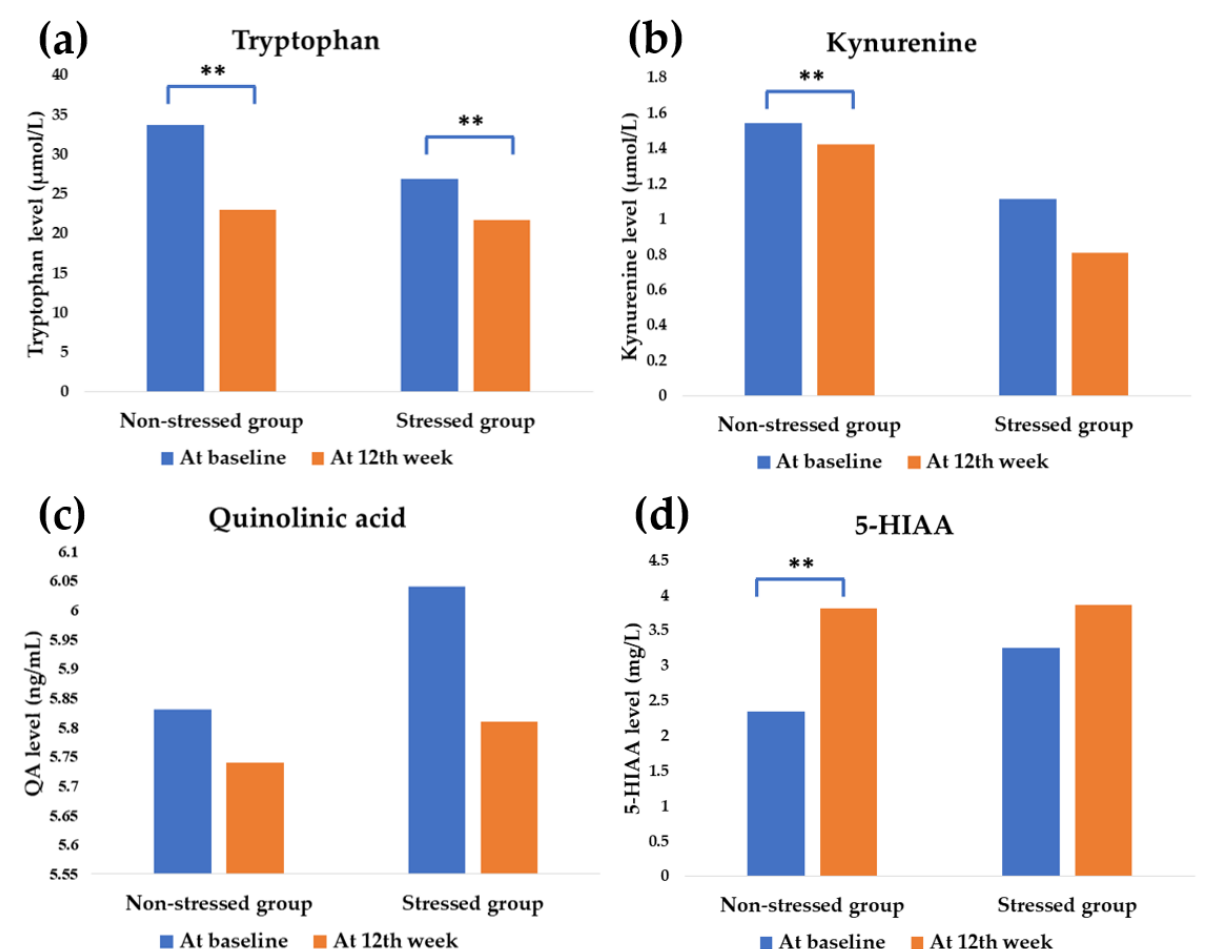
Figure 5. Effect on tryptophan metabolites. The blue and orange bar shows the values at baseline and the 12th week of synbiotics administration, respectively. ** significant difference ( p less than 0.05). 5-HIAA = 5-Hydroxyindoleacetic acid. The tryptophan modulation on kynurenine pathway: